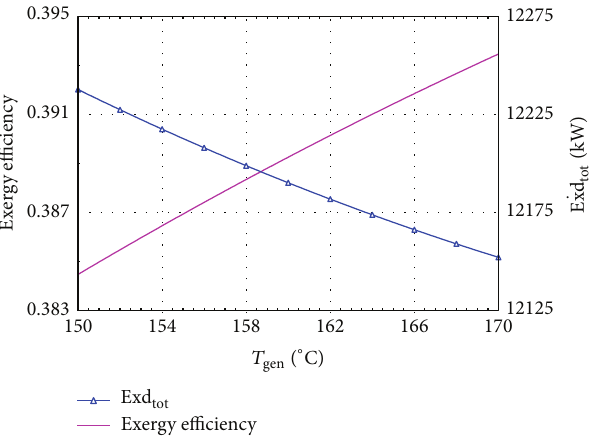
Figure 8: Variation with absorption generator temperature of exer- gy efficiency and total exergy destruction rate.